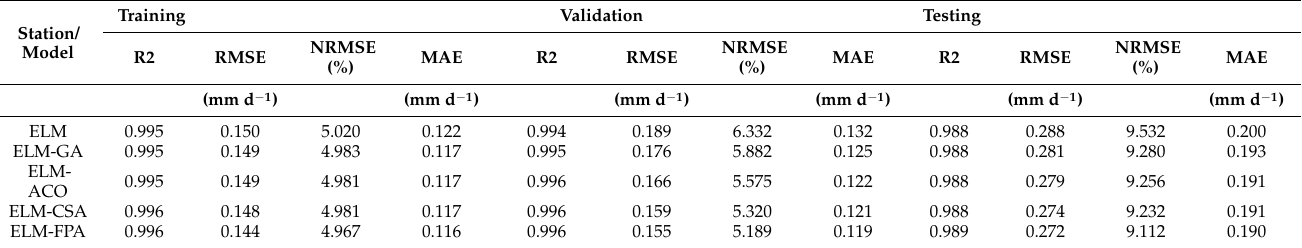
Table 1. Evapotranspiration data collected using ELM statistical methods and bio-inspired algorithms